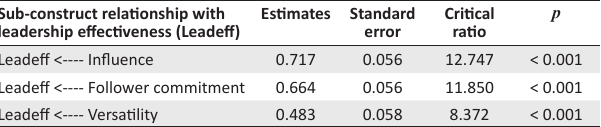
TABLE 11: Structural model parameter estimates and p -values for leadership effectiveness and its constructs.